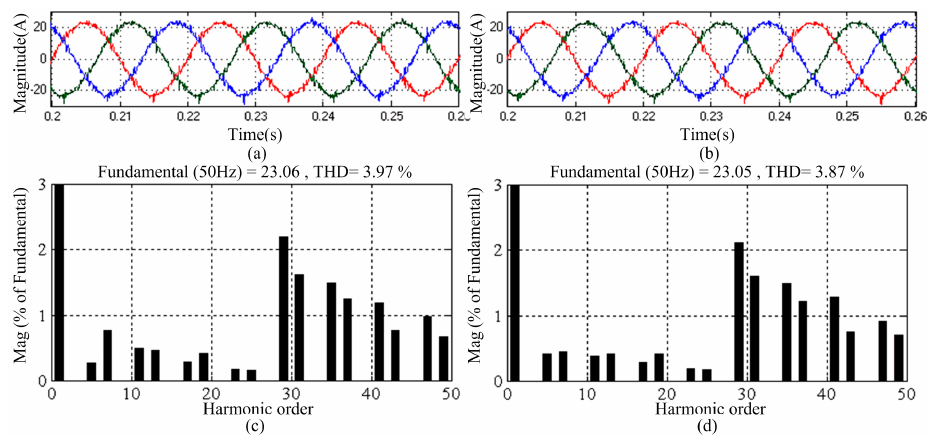
Figure 7. Output current of phase A on L g and the fast Fourier transform (FFT) analysis. ( a ) Output current waveform by using the proposed control strategy; ( b ) output current waveform by using PR controllers; ( c ) output current waveform by using VPI controllers; ( d ) FFT analysis of current in ( a ); ( e ) FFT analysis of current in ( b ); and ( f ) FFT analysis of current in ( c ). Energies 2017 , 10 , 112